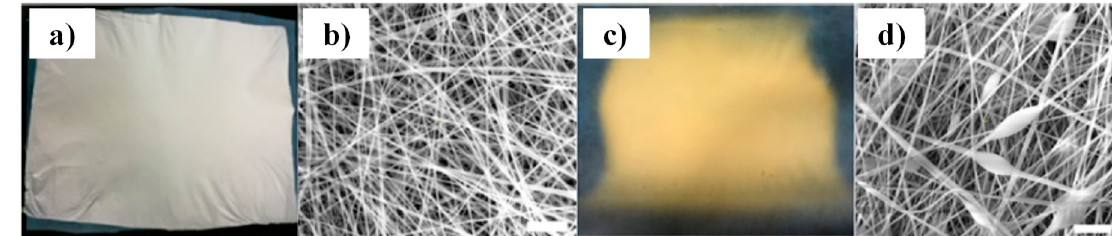
Figure 14. ( a ) Digital photo and ( b ) SEM image of the pure PAN film. ( c ) Digital photo and ( d ) SEM image of the PAN@COF film. Reprinted with permission from [74]. Copyright (2020) American Chemical